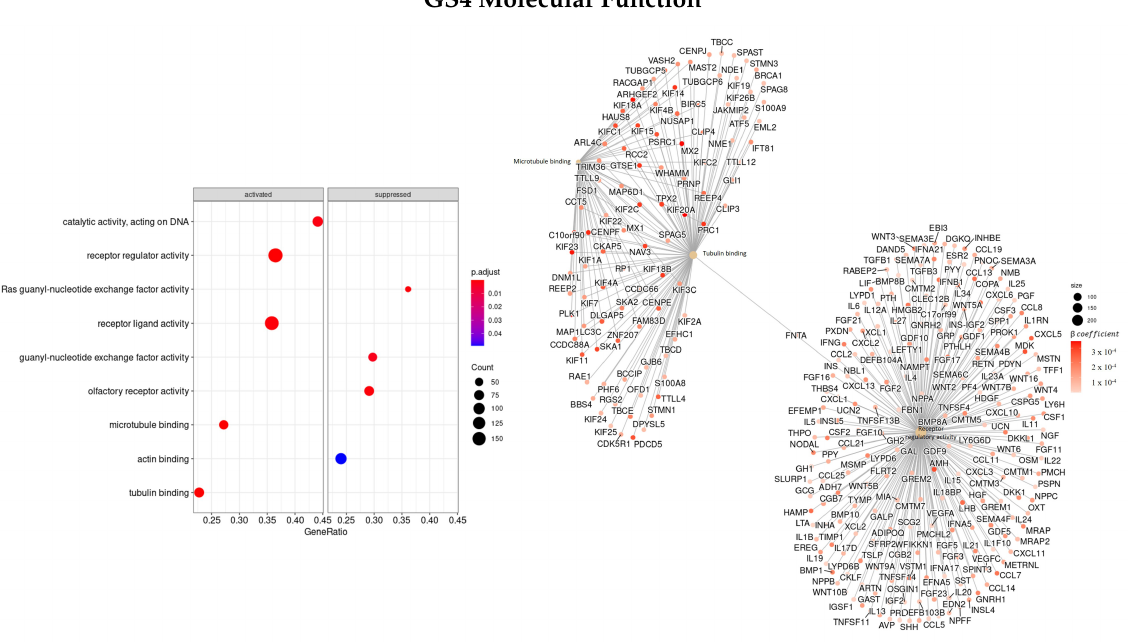
Figure 11. Gene ontology enrichment analysis regarding molecular function terms for a list of genes selected by TCox ranked by the β coefficients of the regression. The left panel shows a dot chart with the most significant MF terms. The right panel shows a gene-concept network plot of the three most enriched terms that depicts the linkages of genes and biological concepts as a